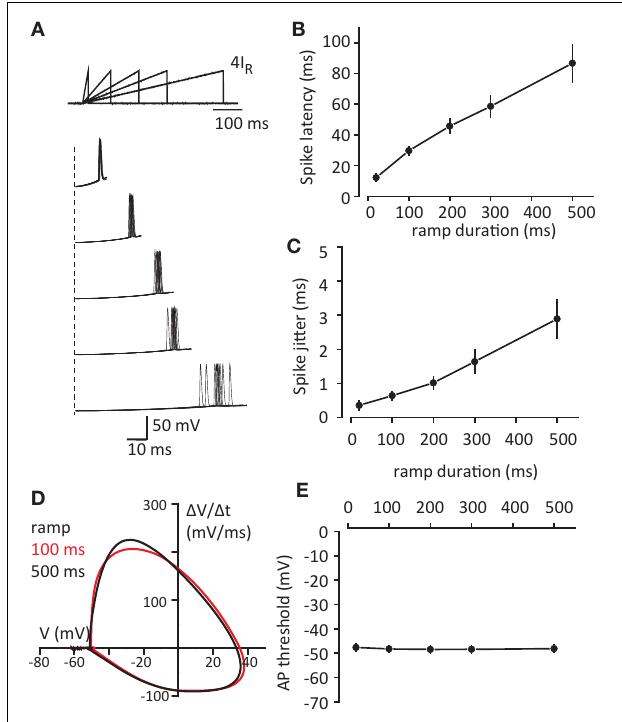
FIGURE 2 | Increase in voltage slope decreases spike latency and spike jitter. (A) Sample traces of APs in response to current injection ramps (4IR; 10, 100, 200, 300, 500ms). Top , schematic of the ramps. Bottom , first spikes to ramps repeated 10 times for each duration. Please note different time scales for top and bottom panels. (B,C) Summary data for the first spike latency and spike jitter in response to different current ramps, respectively. (D) Phase plot of first APs in response to 100ms and 500ms ramps which were used for AP threshold detection. (E) Summary of AP threshold for different current ramps. Data presented as mean ± s.e.m. (error bars). Statistical comparison is discussed in the text.